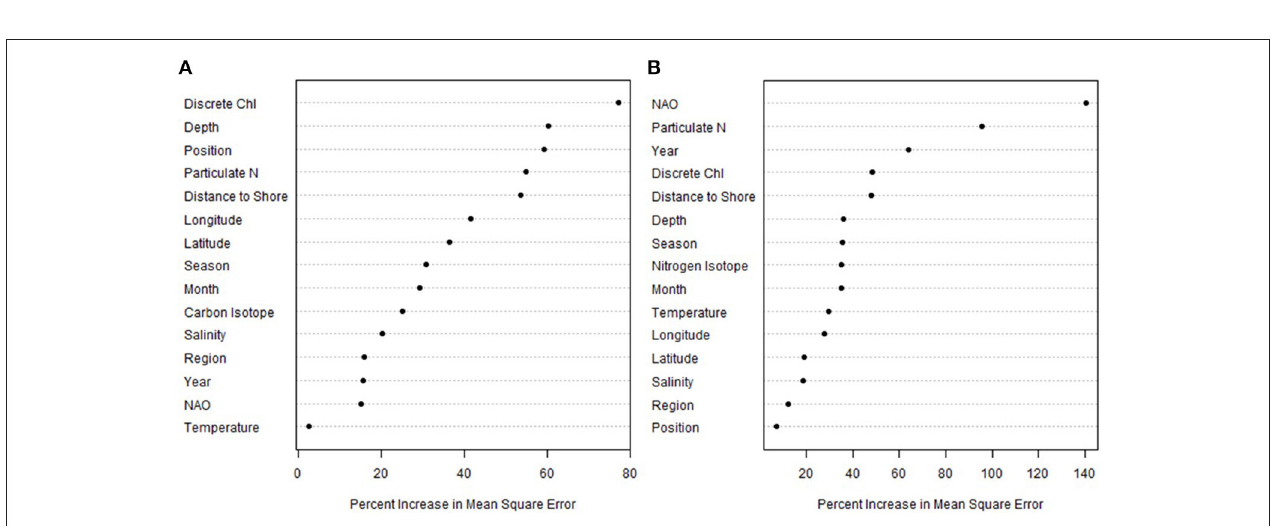
FIGURE 4 | Variable importance plot of the Phase II particulate nitrogen (A) and carbon (B) random forest models. Plotted according to sorted percent increase mean square error; higher values indicate a higher influence on predicting particulate isotope values. See Table 2 for a description of